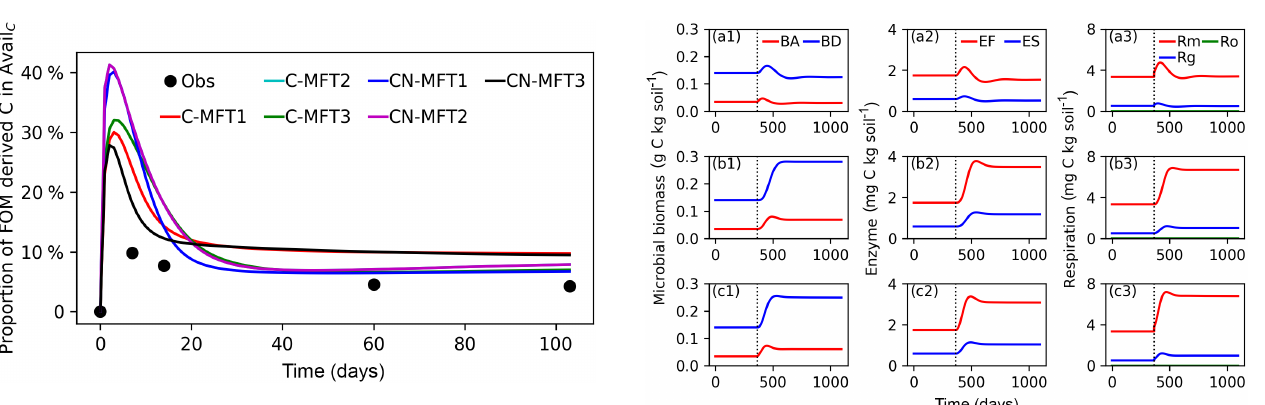
Figure 5. Modeled and observed proportions of FOM derived C in the Avail C pool. The curve of the C-MFT2 modeled curve overlaps with the CN-MFT2 curve.